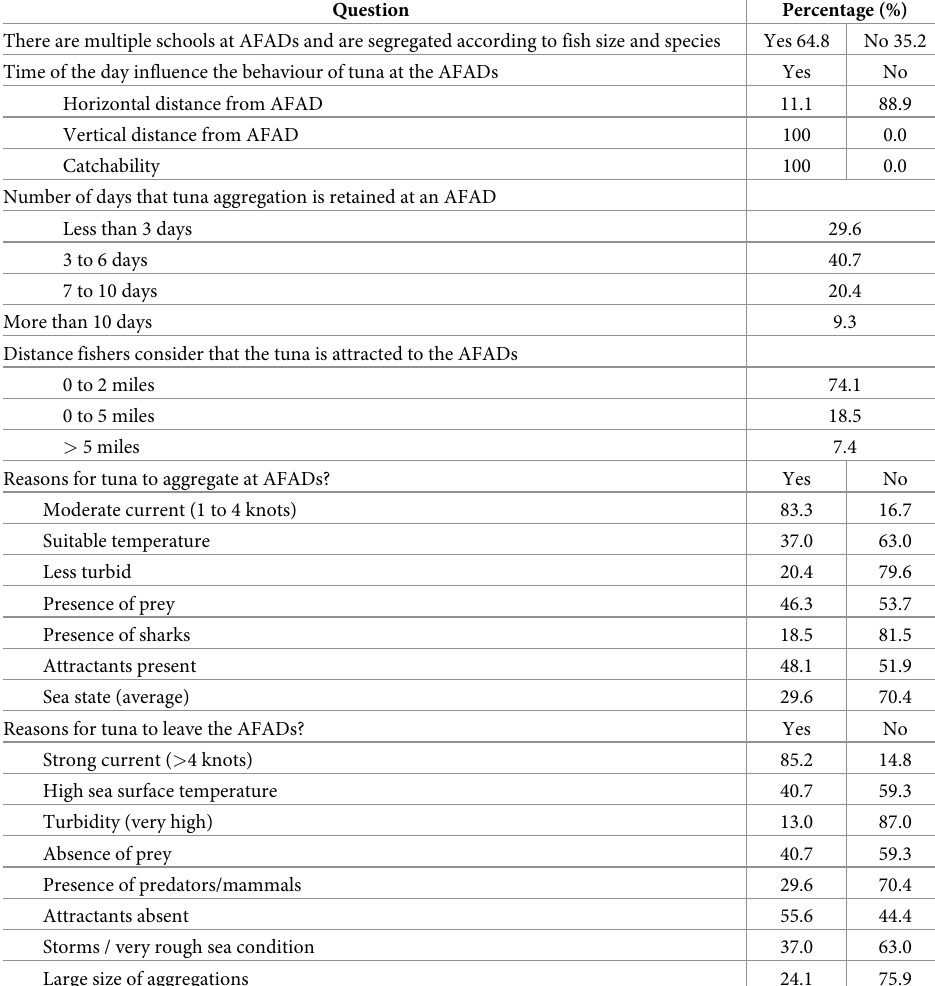
Table 2. Fishers’ responses related to formation of aggregation at AFADs, at the scale of individual AFADs. Question Percentage (%) There are multiple schools at AFADs and are segregated according to fish size and species Yes 64.8 No 35.2 Time of the day influence the behaviour of tuna at the AFADs Yes No Horizontal distance from AFAD 11.1 88.9 Vertical distance from AFAD 100 0.0 Catchability 100 0.0 Number of days that tuna aggregation is retained at an AFAD Less than 3 days 29.6 3 to 6 days 40.7 7 to 10 days 20.4 More than 10 days 9.3 Distance fishers consider that the tuna is attracted to the AFADs 0 to 2 miles 74.1 0 to 5 miles 18.5 > 5 miles 7.4 Reasons for tuna to aggregate at AFADs? Yes No Moderate current (1 to 4 knots) 83.3 16.7 Suitable temperature 37.0 63.0 Less turbid 20.4 79.6 Presence of prey 46.3 53.7 Presence of sharks 18.5 81.5 Attractants present 48.1 51.9 Sea state (average) 29.6 70.4 Yes No Strong current ( > 4 knots) 85.2 14.8 High sea surface temperature 40.7 59.3 Turbidity (very high) 13.0 87.0 Absence of prey 40.7 59.3 Presence of predators/mammals 29.6 70.4 Attractants absent 55.6 44.4 Storms / very rough sea condition 37.0 63.0 Large size of aggregations 24.1